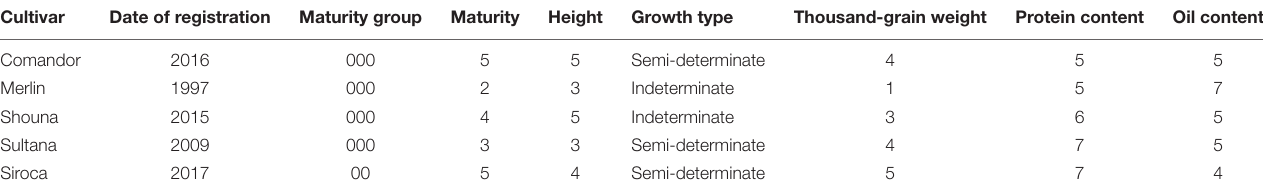
TABLE 1 | Characteristics of soybean cultivars. Cultivar